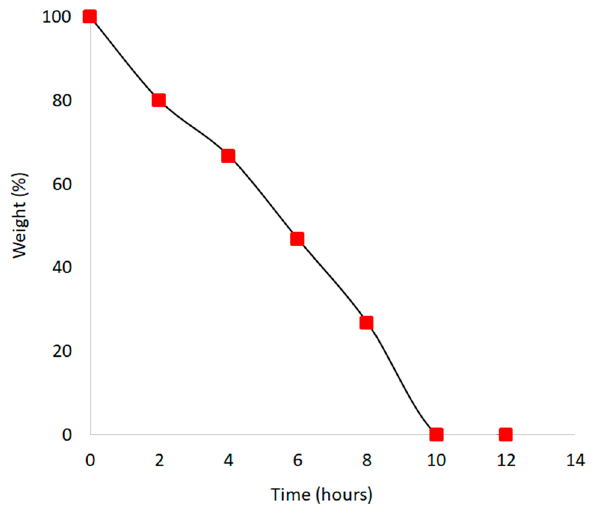
Figure 4. Biodegradation of the co-polymer in the soil of the eastern hills in Bogotá, Colombia. Percentage of mass as a function of time in hours.